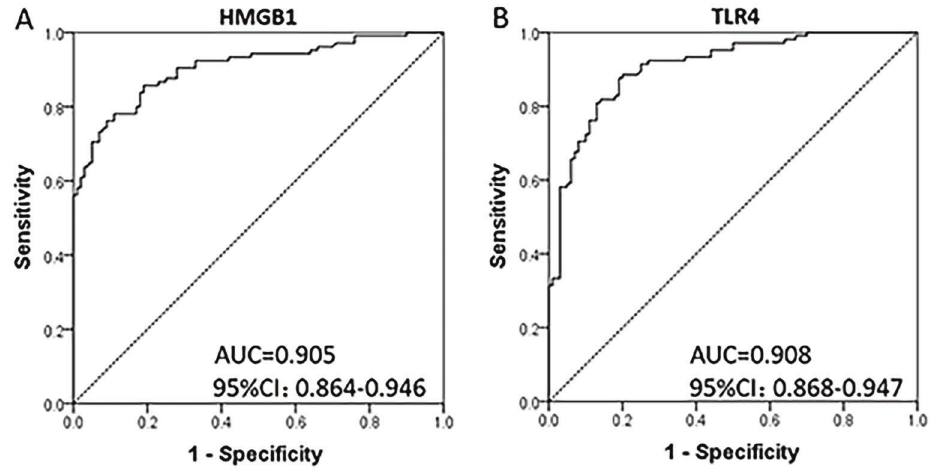
Figure 2. Receiver operating characteristic curves of HMGB1 ( A ) and TLR4 ( B ) for risk of epilepsy. TLR4, toll-like receptor 4; HMGB1, high-mobility group box-1.